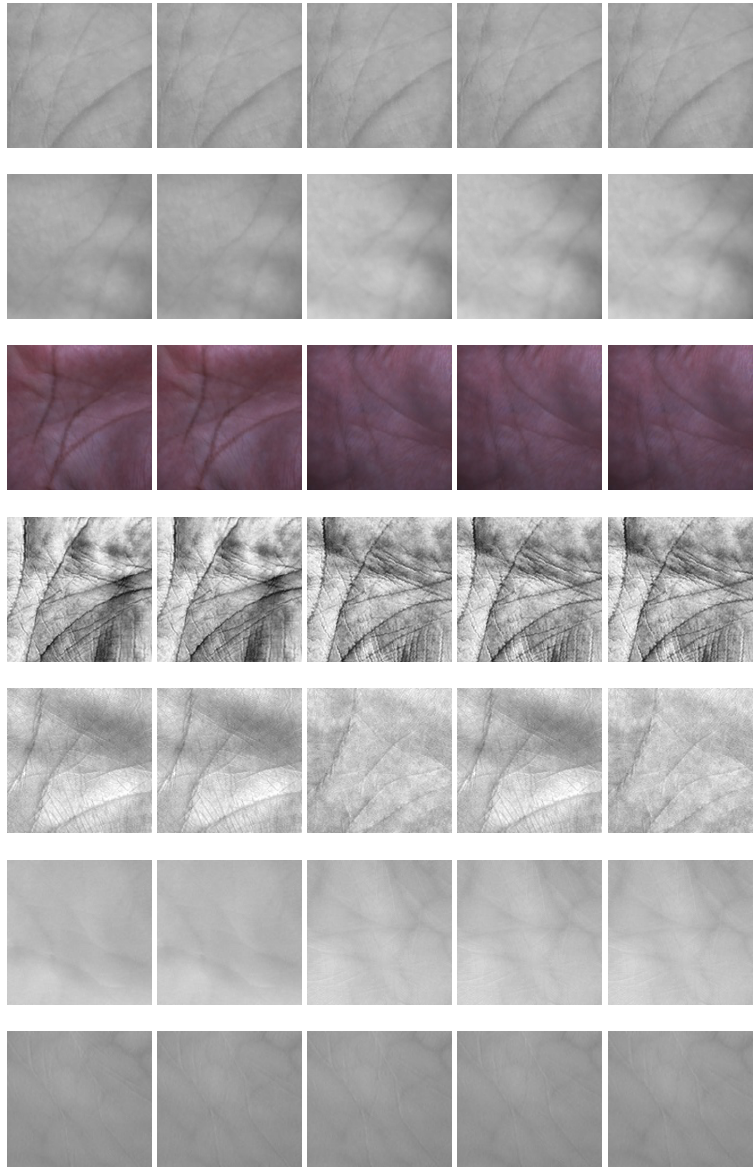
Figure 6. Some typical palmprint ROI samples, where the samples from the first to the fifth lines are from the CASIA [36], GPDS [37], TJI [5], IITD [38], PolyU [40], PV_790 [19], and M_NIR [41] databases,